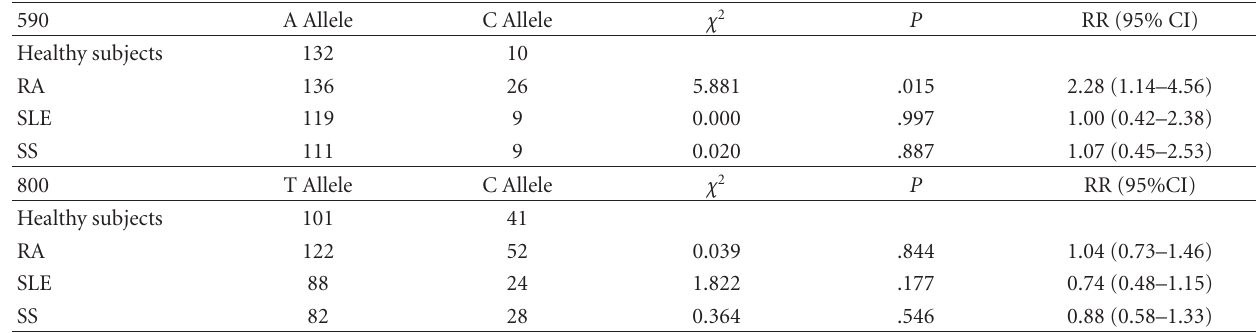
Table 3: Association of 590C allele of human BTLA gene with susceptibility to rheumatoid